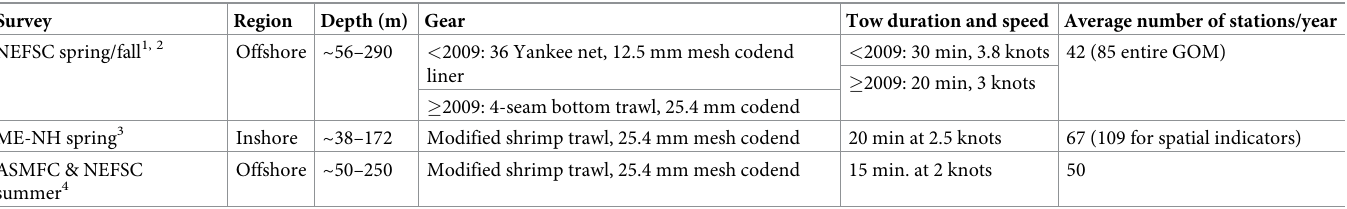
Table 1. Meta-data for fishery-independent surveys used.